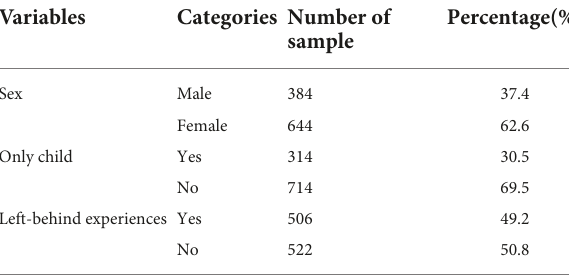
TABLE 1 Descriptive table of participant characteristics. TABLE 2 Correlation analysis table between childhood traumatic